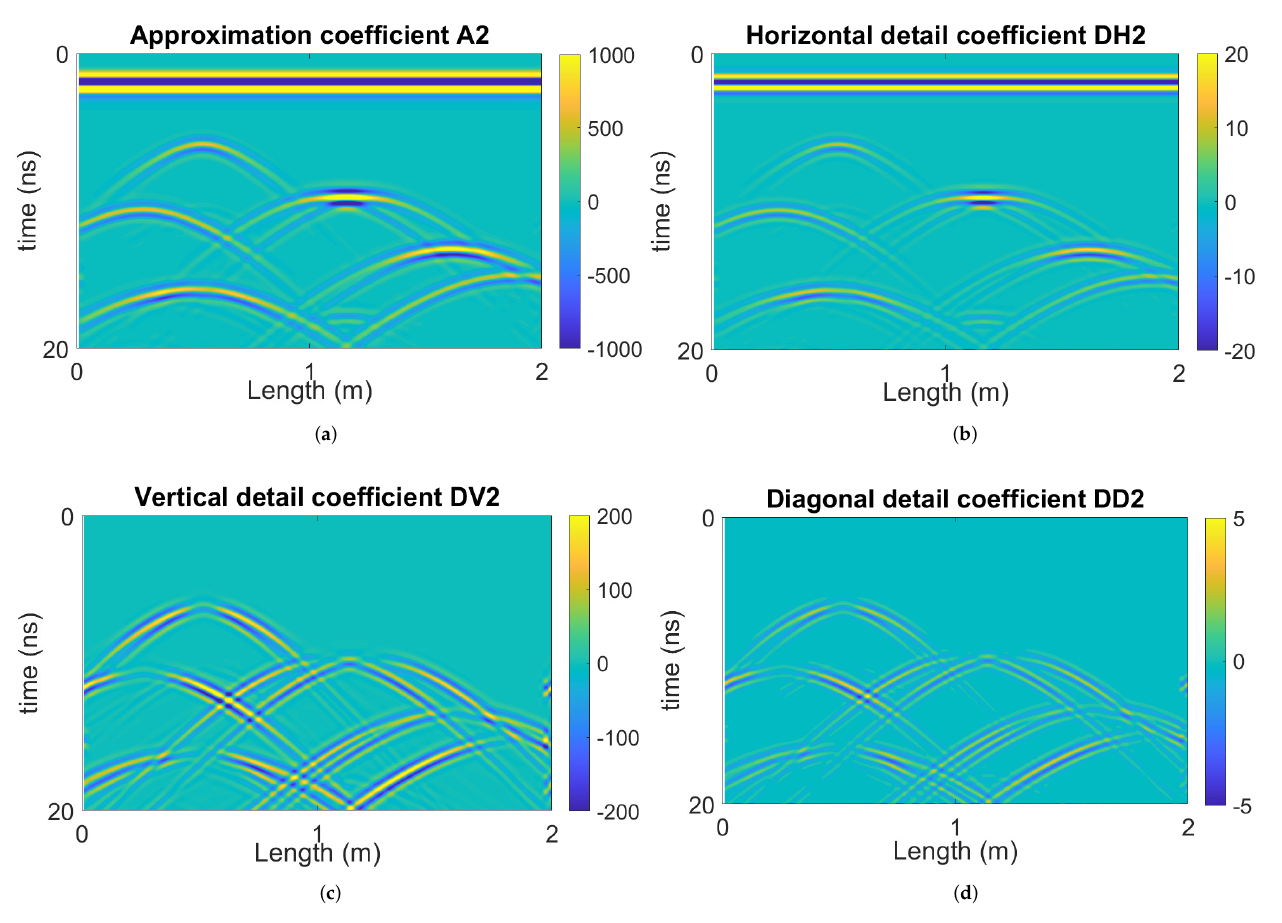
Figure 5. Second layer ( a ) approximation coefficient A 2 , ( b ) horizontal detail coefficient DH 2 , ( c ) vertical detail coefficient DV 2 , and ( d ) diagonal detail coefficient DD 2